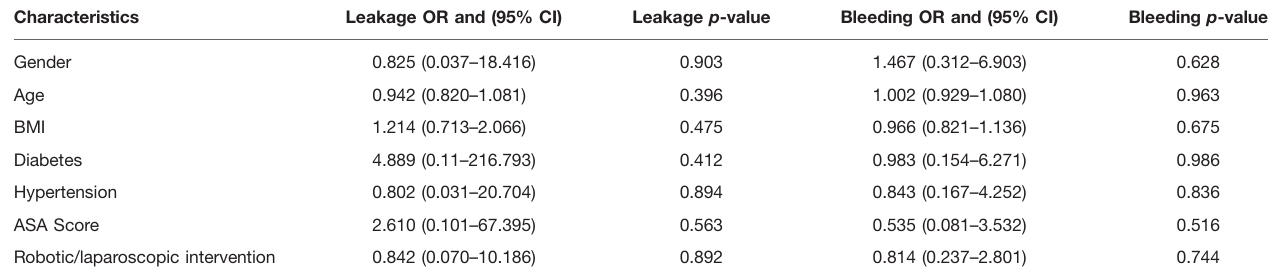
TABLE 5 | Results of the multivariate analysis.